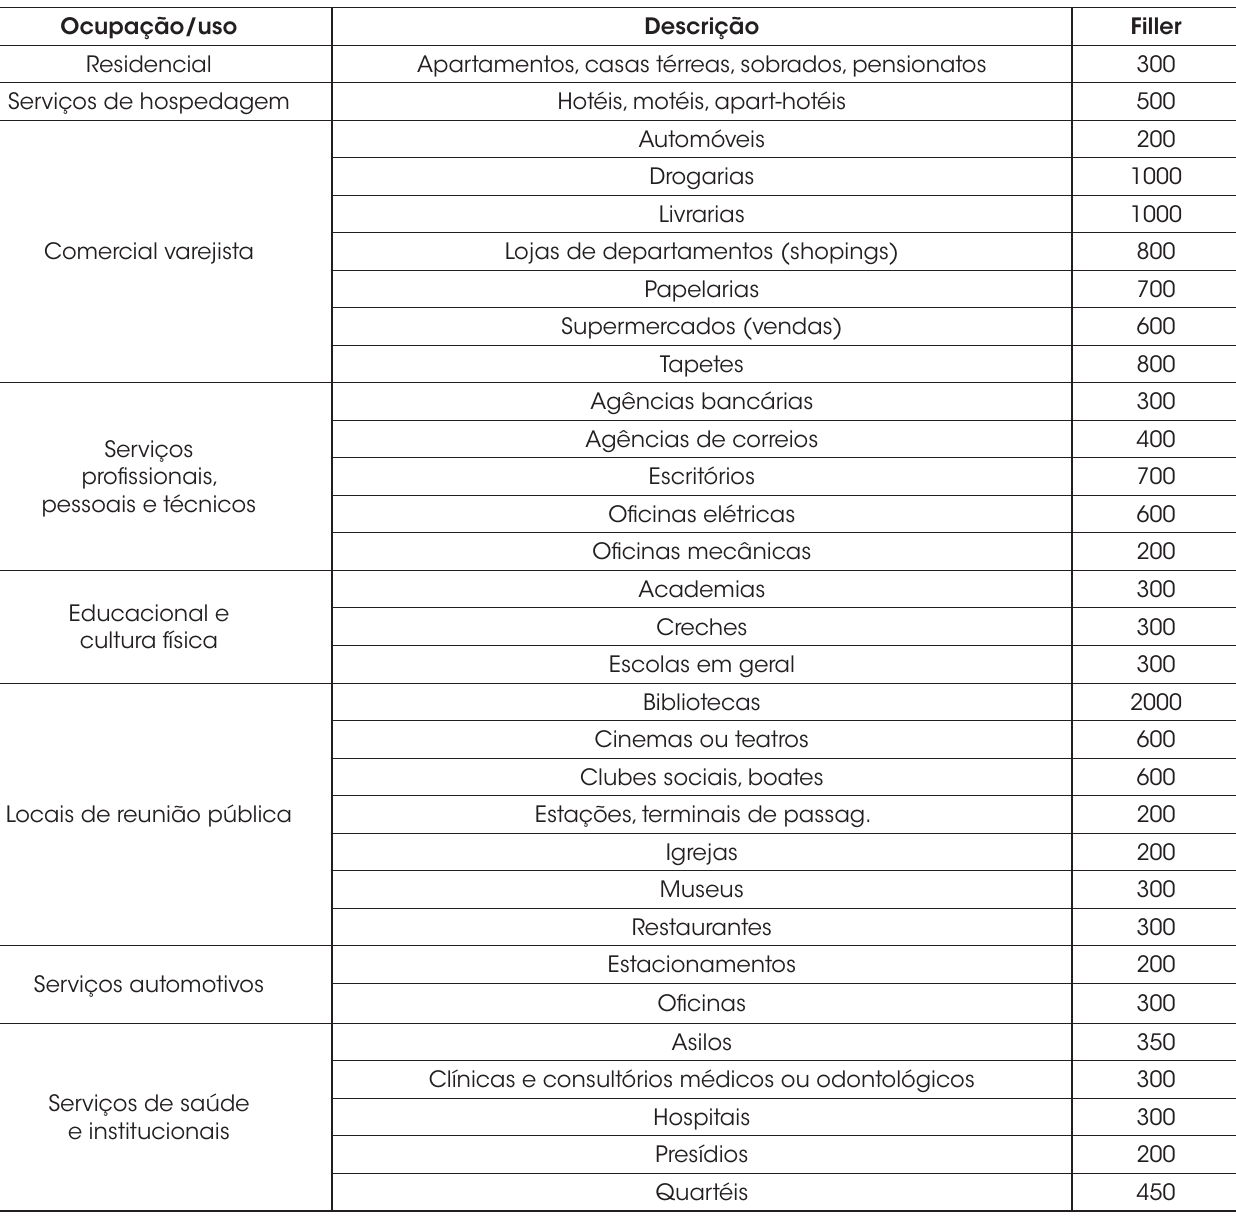
Valores de cargas de incêndio específicas (IT14, 2011) Ocupação/uso